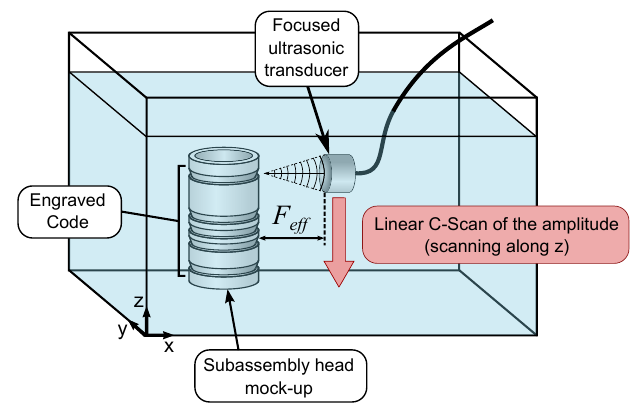
Fig. 2. Schematic diagram of the in-sodium experiment.